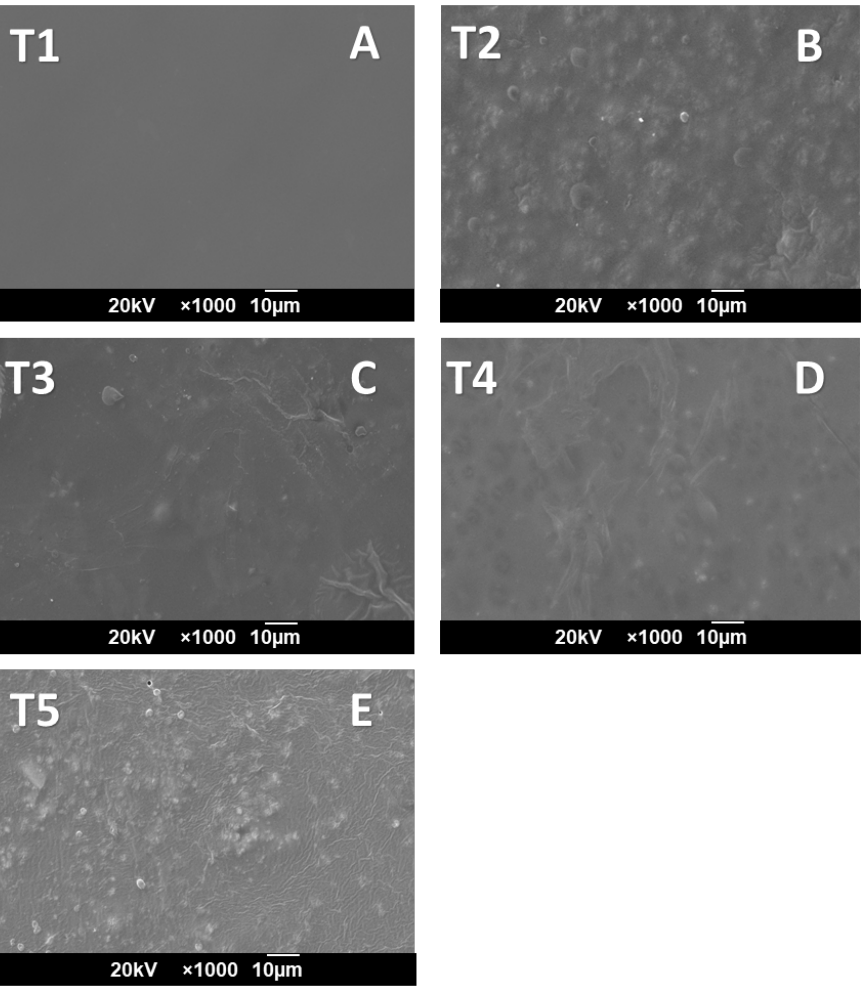
Figure 4. Morphological analysis of slides by scanning electron microscopy (SEM): T1, ( A ) gelatin/cassava starch 0:100; T2, ( B ) gelatin/cassava starch 25/75; T3, ( C ) gelatin/cassava starch 50/50; T4, ( D ) gelatin/cassava starch 75/25; T5, ( E ) gelatin/cassava starch 100/0.